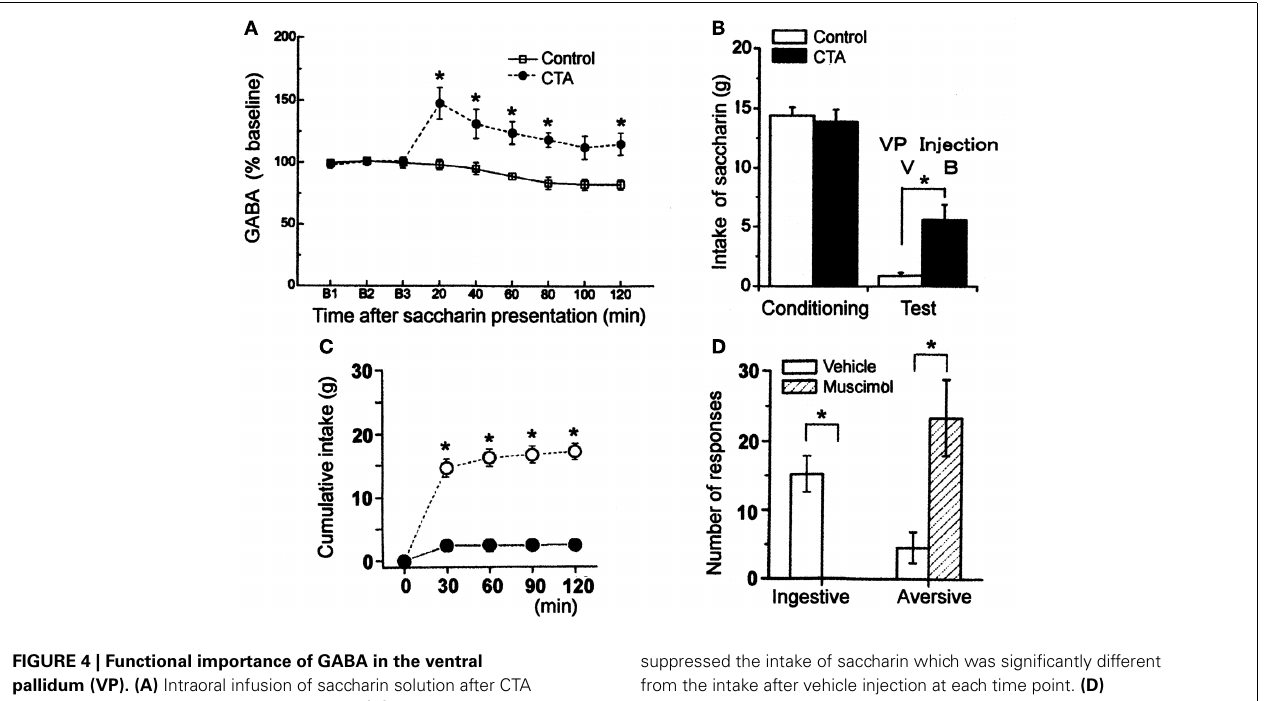
FIGURE 4 | Functional importance of GABA in the ventral pallidum (VP). (A) Intraoral infusion of saccharin solution after CTA acquisition increased GABA release in theVP. (B) The intake of saccharin in the vehicle-injected control group (V) was very small after CTA acquisition, but it increased significantly after microinjection of bicuculline [50ng (B) ]. (C) Muscimol (100ng) injected into theVP